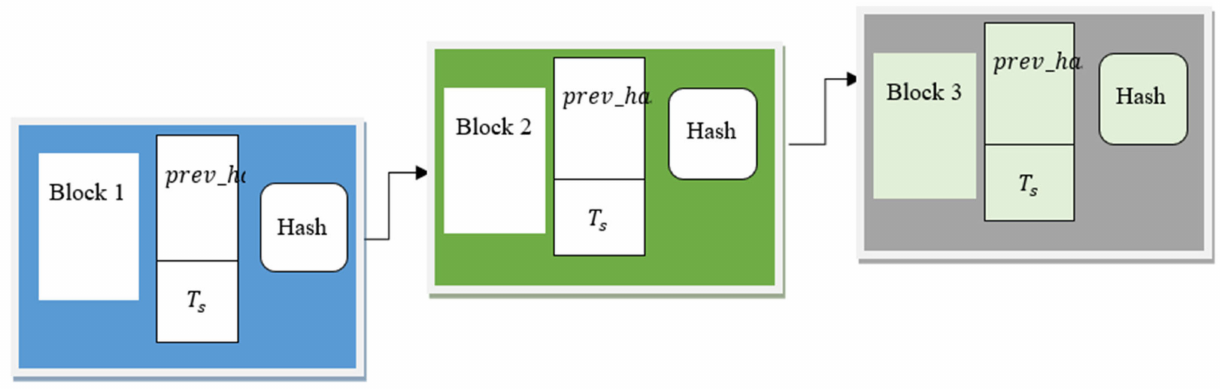
Figure 4. Structure of Miyaguchi-Preneel cryptographic hash-based blockchain for block header, timestamp ( T s ), hash, and a hash of the previous block ( prev _ hash ).